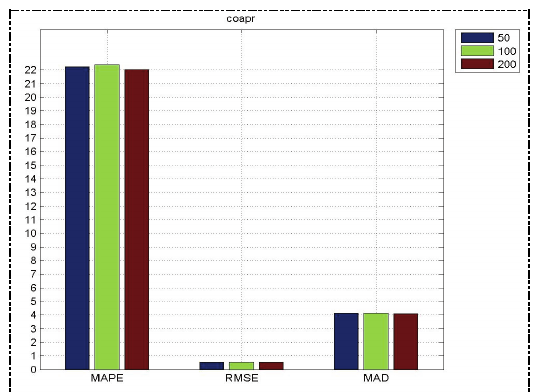
Fig.7. Performance evaluation graph of MAPE, RMSE and MAD values of various hidden layers in proposed technique for dataset